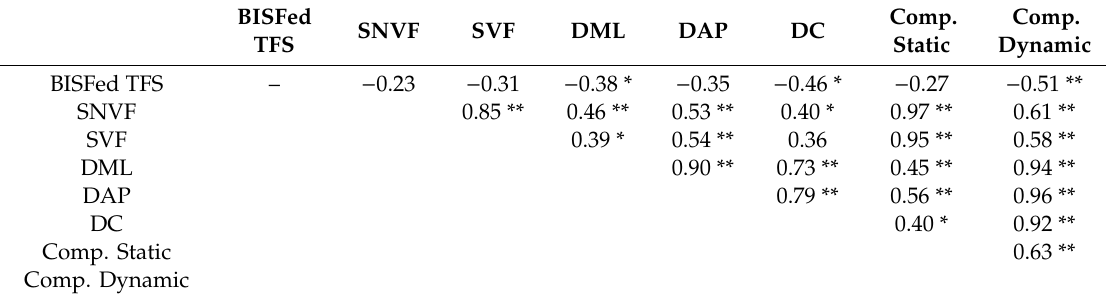
Comp. Static 0.63